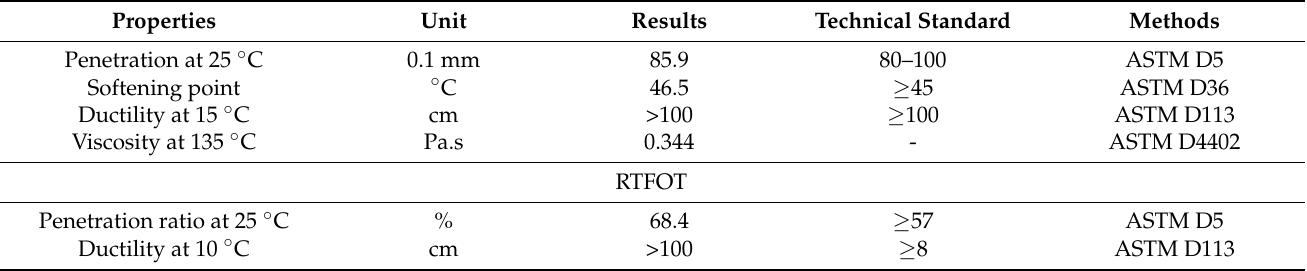
Table 1. Physical characteristics of SK-90# asphalt binder.